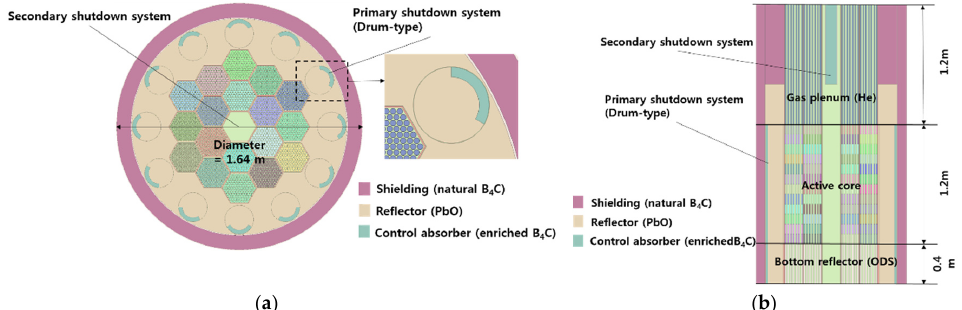
Figure 2. Radial and axial configurations of the KAIST MMR. ( a ) Radial configuration and drum ‐ type control system; ( b ) axial configuration. Table 1. Design parameters of KAIST micro modular reactor (MMR).